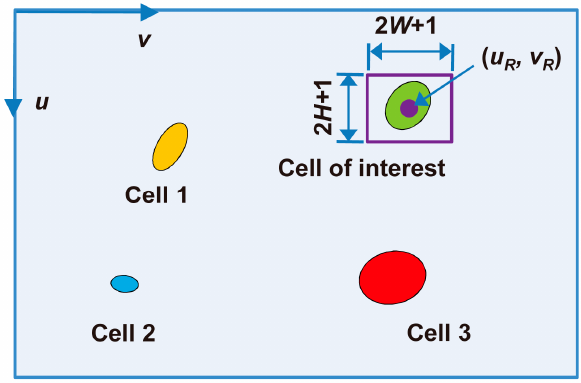
Figure 2. Selection of the cell of interest in the first frame. The cell of interest was manually selected with a rectangle, whose size should be as small as possible under the premise of covering the cell of interest.